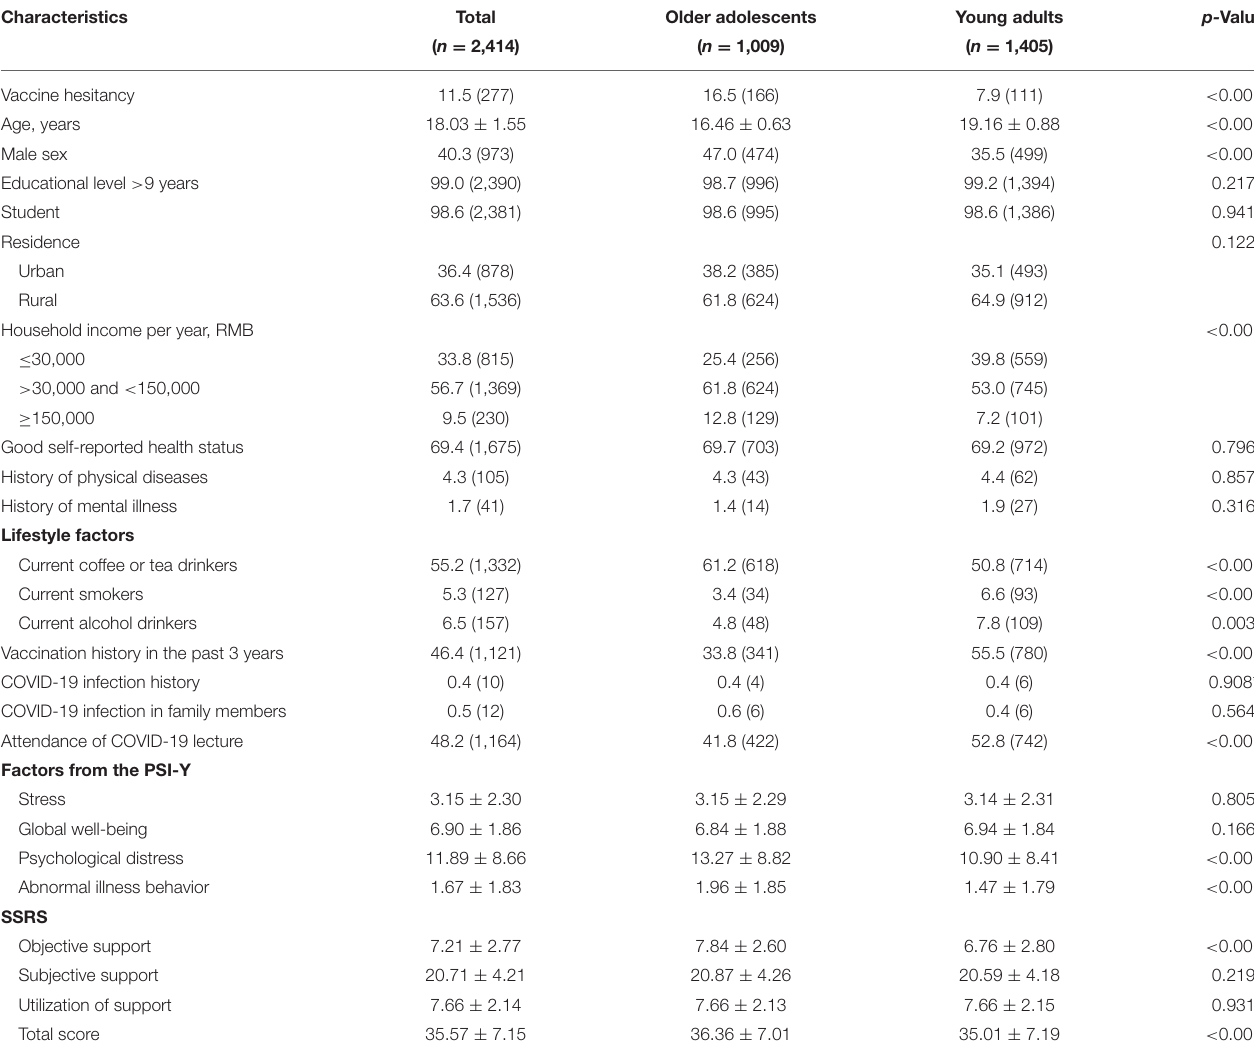
TABLE 1 | Sociodemographic characteristics in older adolescents vs. young adults.